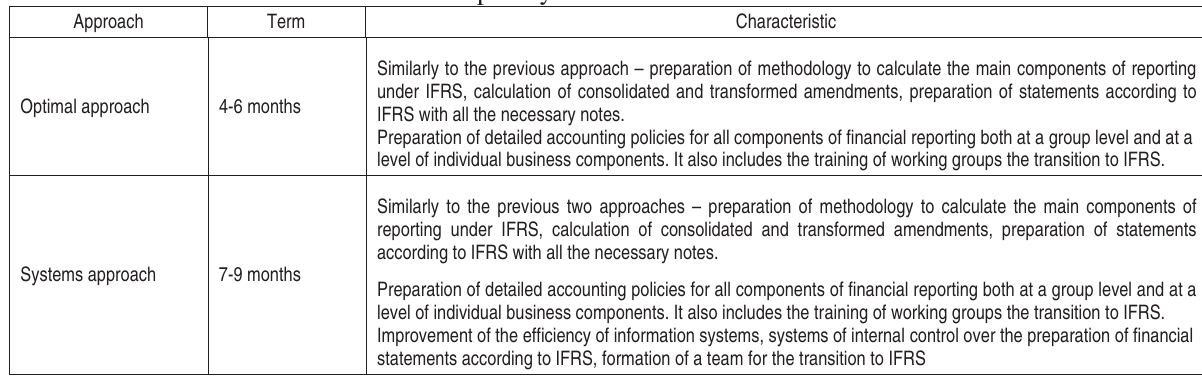
Table 3 (cont.). Approaches to the transformation of the reporting regarding the timing and complexity of transition to